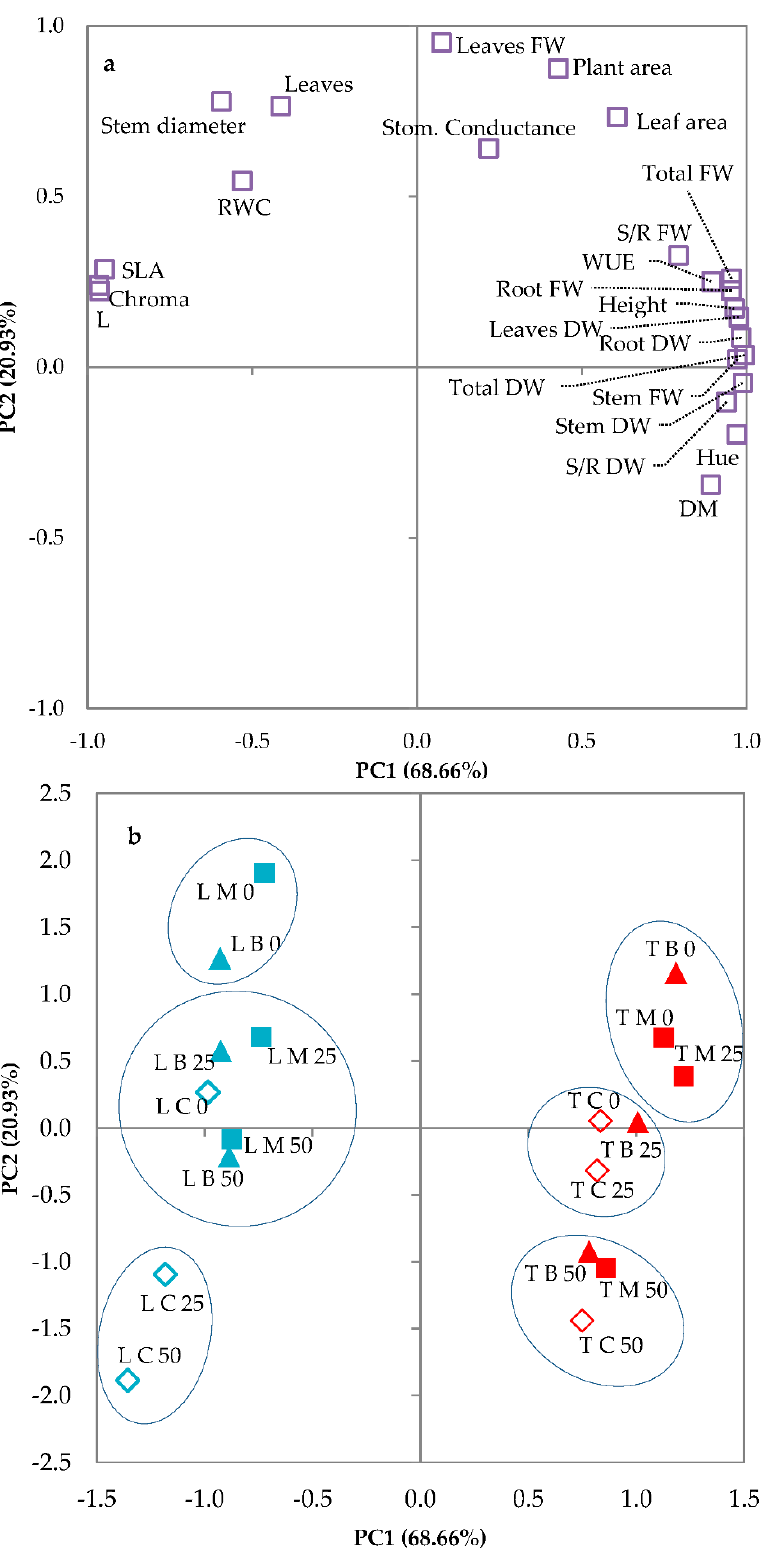
Figure 6. Plots of ( a ) loadings (morphophysiological characteristics of lettuce and tomato seedlings) and ( b ) scores (trials) formed by the two principal components from the Principal Component Analysis (PCA). L C: untreated lettuce seedlings; L B: lettuce seedlings inoculated with Bactorr S13 ; L M: lettuce seedlings inoculated with Micorrize; T C: untreated tomato seedlings; T B: tomato seedlings inoculated with Bactorr S13 ; T M: tomato seedlings inoculated with Flortis Micorrize; 0, 25, and 50: concentration of NaCl (mM) in the irrigation